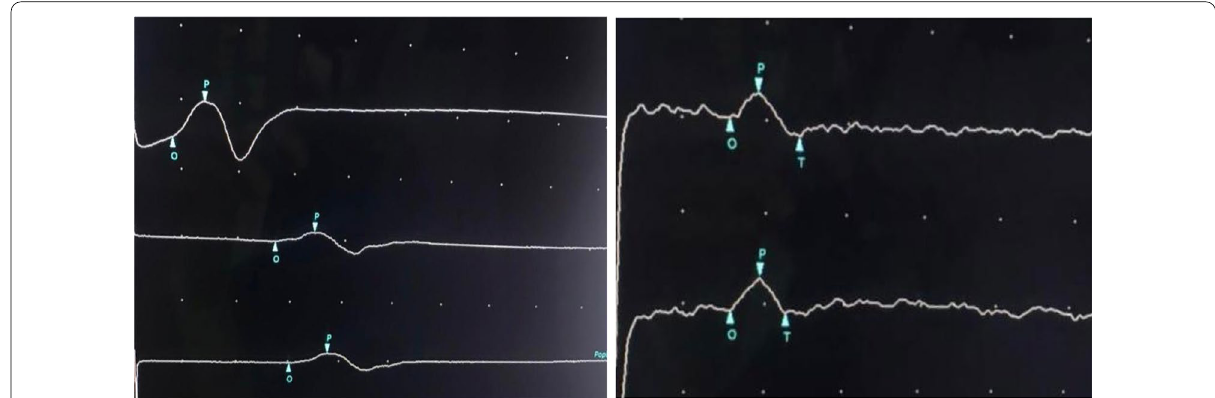
Fig. 1 Low‑amplitude CMAP in bilateral tibial and peroneal nerves. Additionally, polyphasic units, a few positive sharp waves and fibrillation potentials, as well as slow wave resting potential, are present. O : Onset of the wave; P : Peak of the wave; T : Terminal part of the